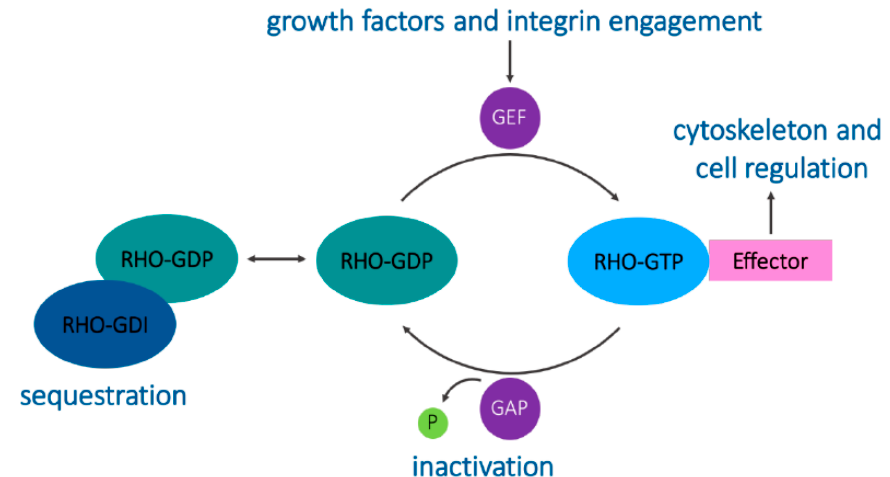
Figure 1. The Rho GTPase cycle. Guanine nucleotide exchange factors (GEFs) catalyze the exchange of GDP for GTP to activate Rho GTPases. GTPase-activating proteins (GAPs) promote GTP hydrolysis to decrease Rho GTPase activity. Rho GDP-dissociation inhibitors (GDIs) sequester Rho GTPases in the cytoplasm, maintaining them in an inactive state. Active Rho GTPases act on their downstream effectors to engage specific signaling cascades.